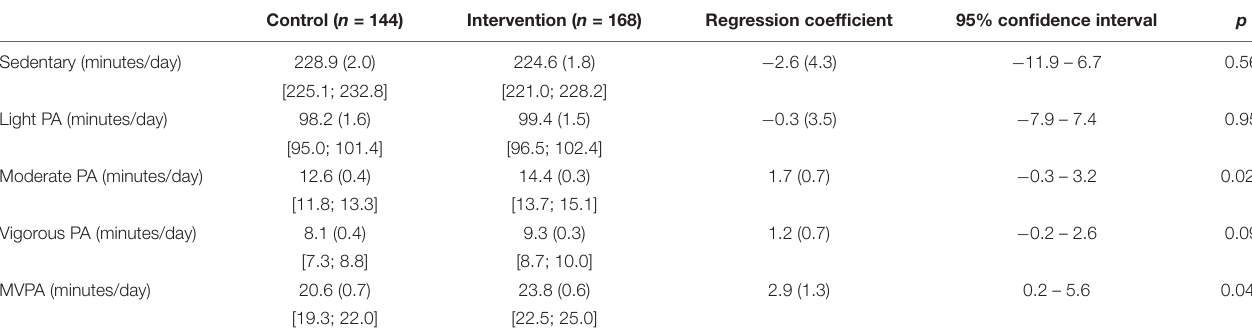
TABLE 3 | Physical activity levels during school hours (means, standard deviations, [95% confidence intervals]) and statistics of the mixed-model analyses. Control ( n = 144) Intervention ( n = 168) Regression